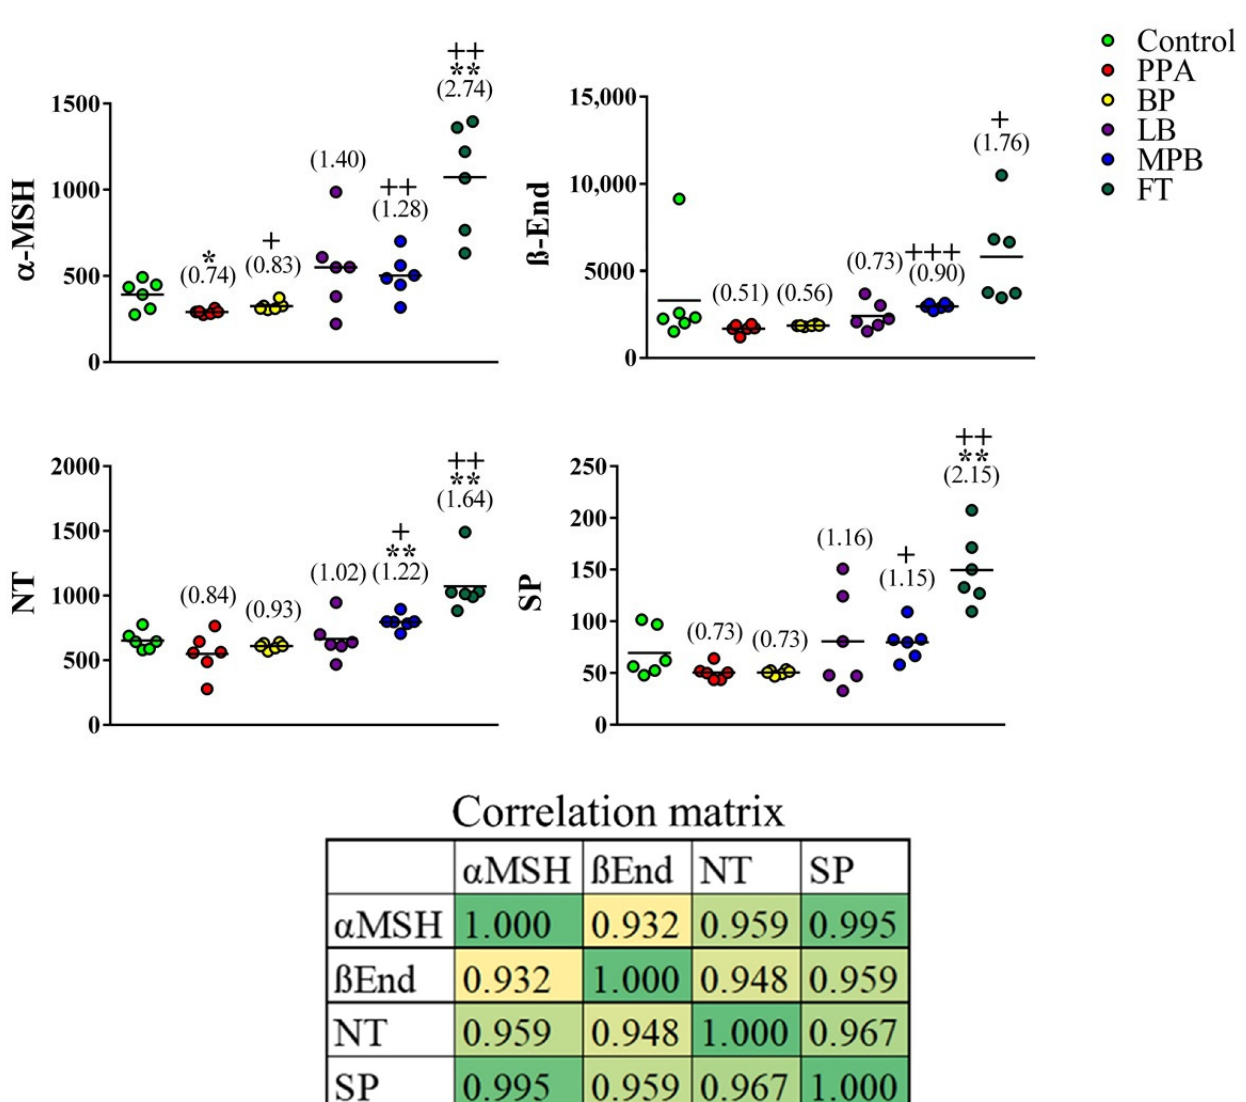
Figure 1. Effects of bee pollen and probiotic intestinal microbiota on neuropeptide levels in a rat model of autism. Unpaired t -test was used to test the significance of differences between the control group and each of the remaining groups. Corresponding p values of <0.05 and <0.005 are indicated by “*” and “**”, respectively. Differences between the PPA group and each of the other non-control groups were similarly tested, and corresponding p values of <0.05, <0.005, and <0.0005 are indicated by “+”, “++”, and “+++”, respectively. Fold change relative to controls is indicated in parentheses. PPA: propionic acid; BP: bee pollen; LB: Lactobacillus ; MPB: mixed probiotic bacteria; FT: fecal transplant. The correlation matrix shows correlations between the neuropeptide levels (bottom). Correlation was calculated using Pearson product–moment correlation analysis. The heatmap shows r values. The p values associated with r at 95% confidence interval are 0.007, 0.002, 0.00004, 0.004, 0.00249, and 0.00158 for α -MSH/ β -End, α -MSH/NT, α -MSH/SP, β -End/NT, β -End/SP, and NT/SP, respectively.